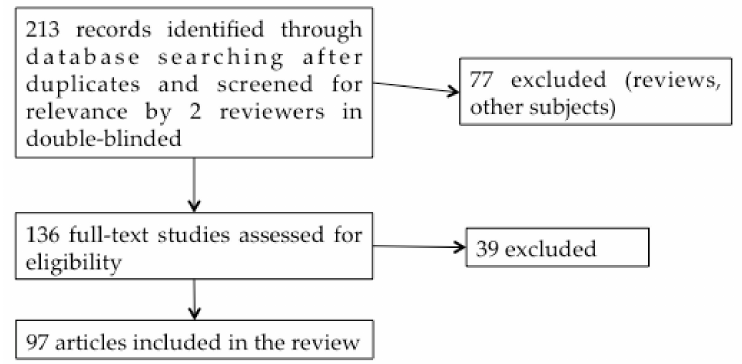
Figure 3. Systematic review flow